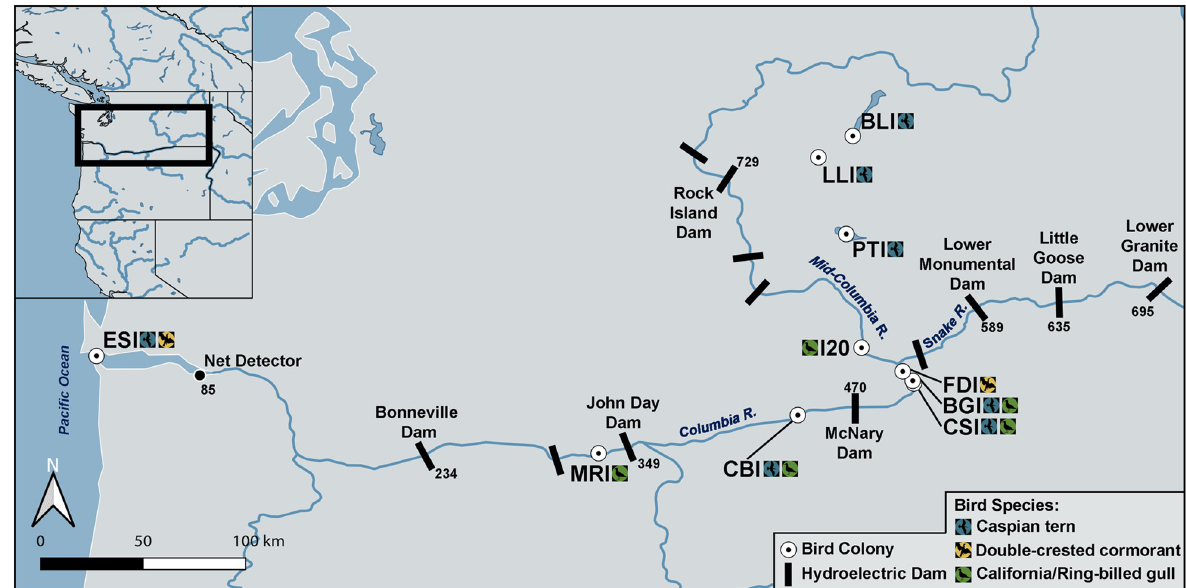
Fig 1. Map of study area. Capture-recapture-recovery locations of tagged juvenile salmonids initially detected passing Lower Granite Dam on the Snake River. Downstream recapture locations include Little Goose Dam, Lower Monumental Dam, McNary Dam, John Day Dam, Bonneville Dam, and a towed net detection system in the upper Columbia River estuary (Net Detector). Recovery locations include bird colonies on Banks Lake Island (BLI), Potholes Reservoir (PTI), Lenore Lake Island (LLI), Island 20 (I20), Foundation Island (FDI), Badger Island (BGI), Crescent Island (CSI), central Blalock Islands (CBI), Miller Rocks Island (MRI), and East Sand Island (ESI). Avian species include Caspian terns, double-crested cormorants, and California/ring-billed gulls. Numbers represent the distance in river km (Rkm) from the Pacific